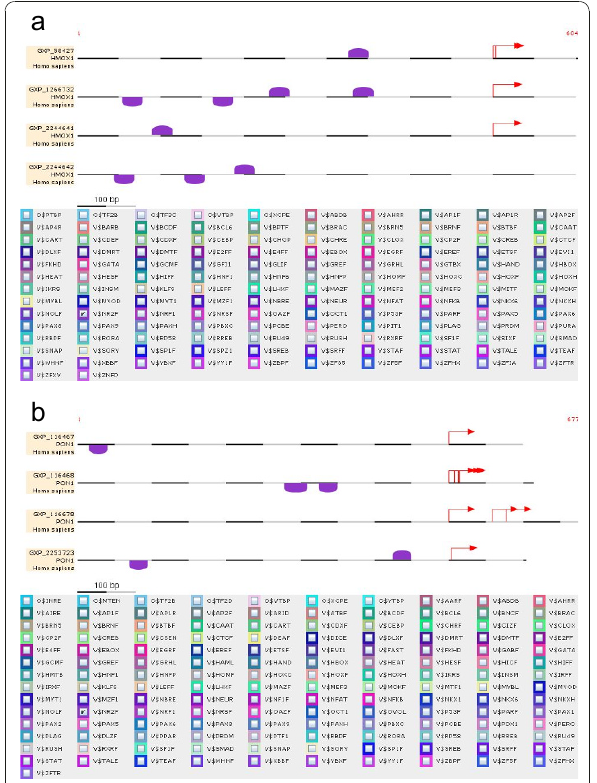
Figure 1 Nrf2 binding sites in alternative promoter sequences of the HO-1 and PON1 gene . Nrf2 binding sites are depicted in alternative promoter sequences of (a) HO-1 (GXP_58427, GXP_1266732, GXP_2244641, GXP_2244642) and (b) PON1